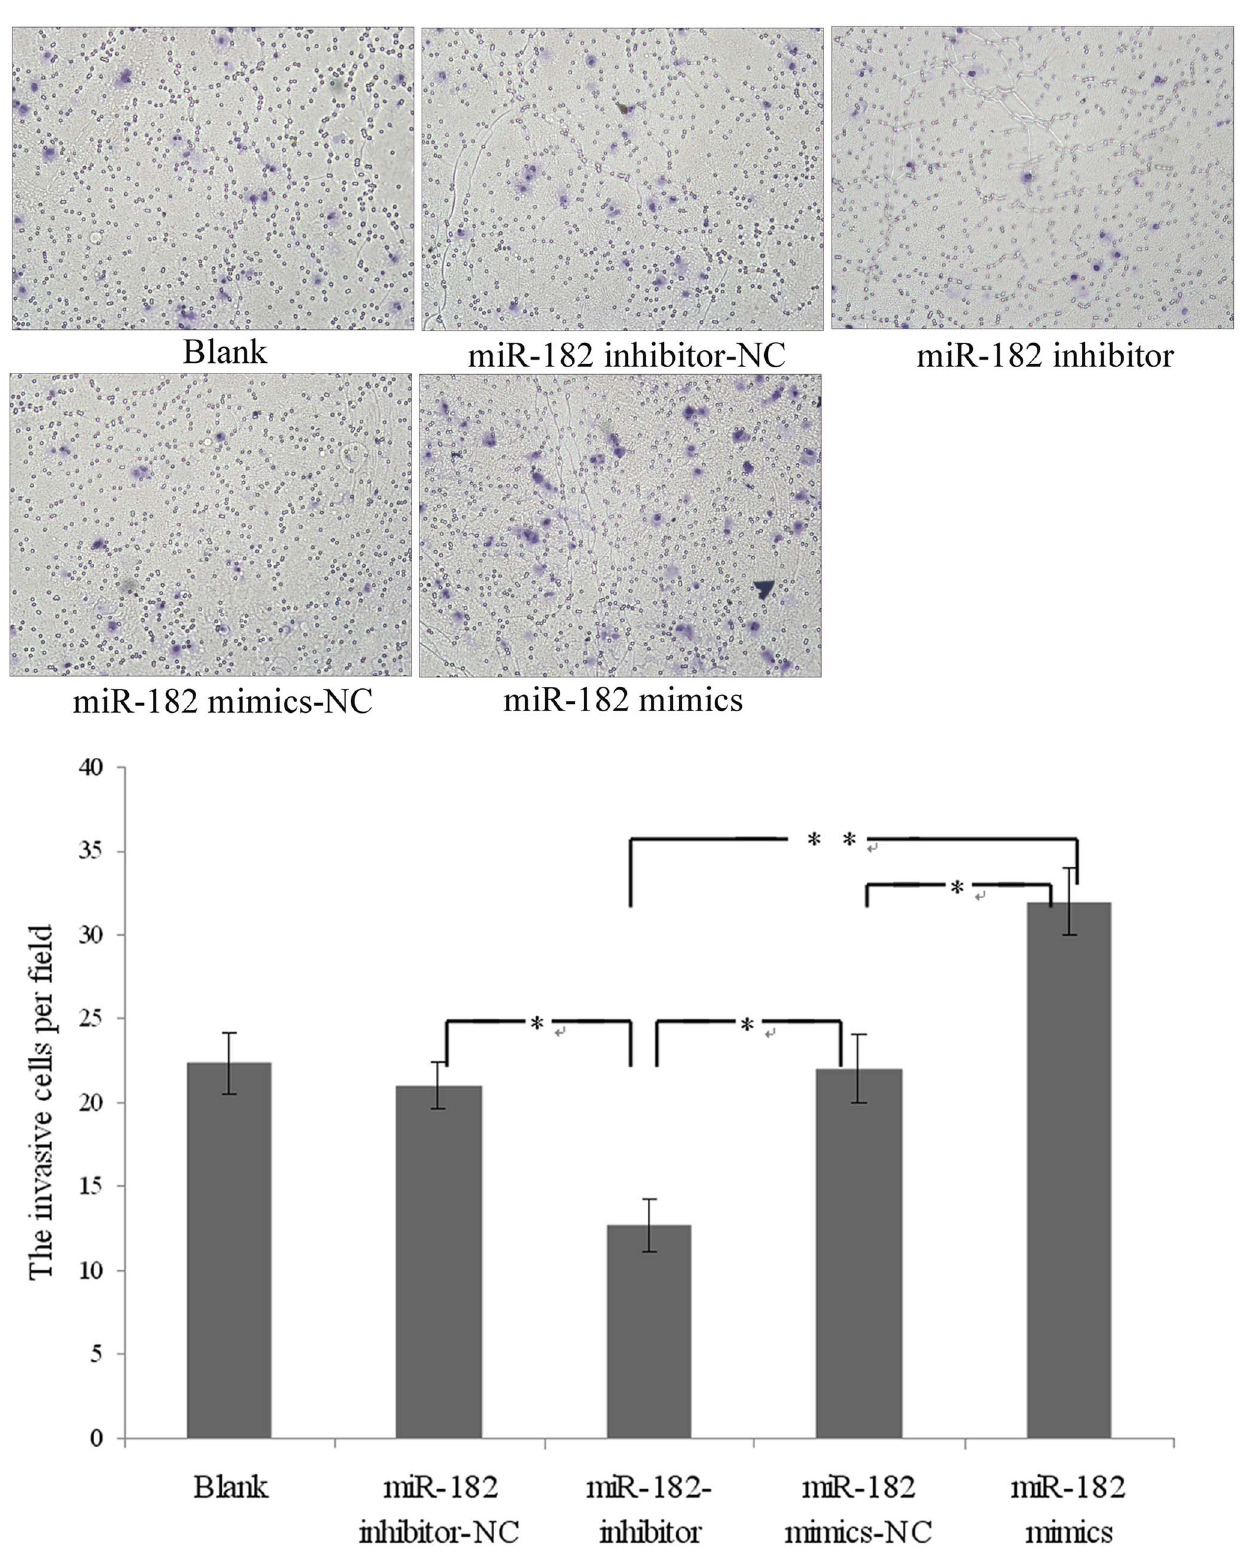
Figure 8. Transwell invasion assay. Invasion assays were performed with PC-3 cells transfected with miR-182 mimics or inhibitors. Blank presents blank control. Representative images and randomly selected fields are shown (* P , 0.05, ** P , 0.01).